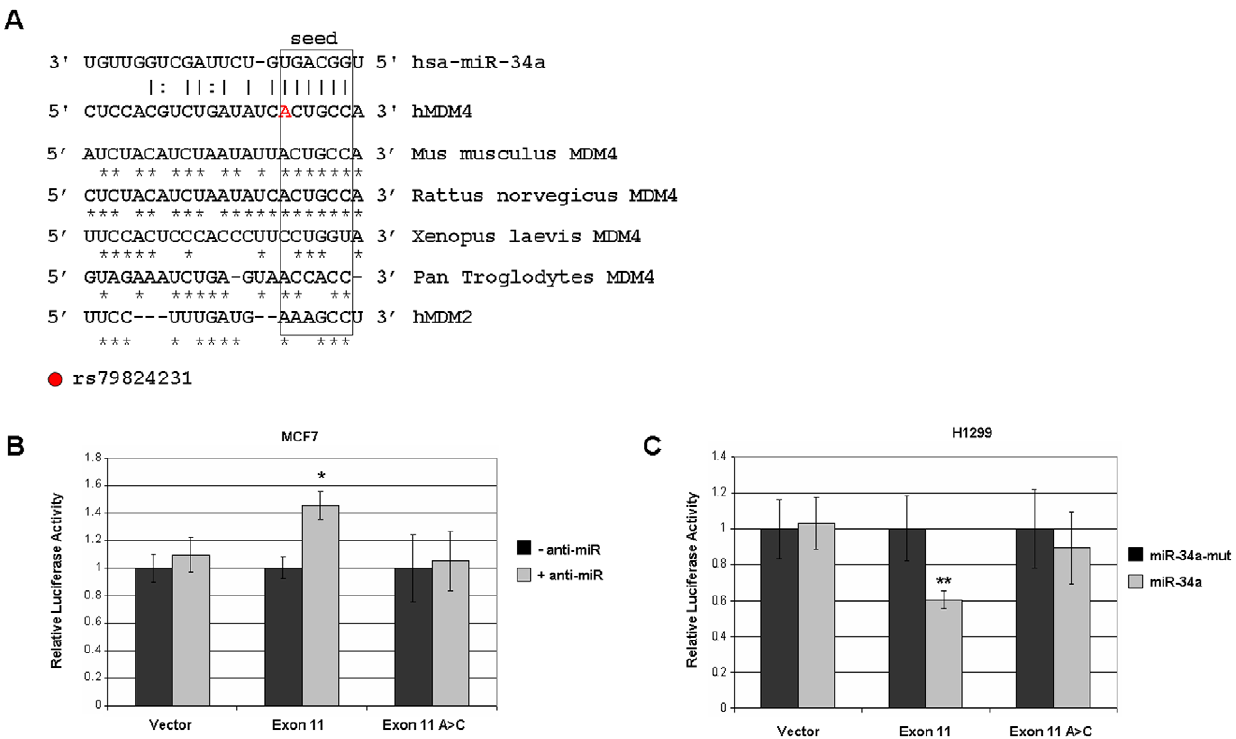
Figure 4. The MDM4 open reading frame contains a functional miR-34a responsive site. (A) Binding site for miR-34a predicted in human MDM4 mRNA by miRanda. Binding is indicated by solid lines, while wobble base pairing is indicated by a dashed line. Identity with the human MDM4 sequence is indicated by asterisks. The seed region of miR-34a, positions 2–7, are boxed. The homologous region of human MDM2 mRNA is also shown for comparison. (B) In MCF7 cells, the miR-34a inhibitor was cotransfected with a reporter gene containing the ORF miR-34a site from MDM4 (‘‘Exon 11 0 ) or the reporter with the rs79824231 SNP (‘‘Exon 11 A . C’’). Data are the averages of at least six independent experiments, with standard deviation indicated in error bars. Asterisks indicate t-test values , 0.5. (C) In H1299 cells, the reporters were cotransfected with an expression plasmid for miR-34a or miR-34a-mut. Data are the averages of at least six independent experiments, with standard deviation indicated in error bars. Double asterisks indicates paired, one-tailed t-test value ,